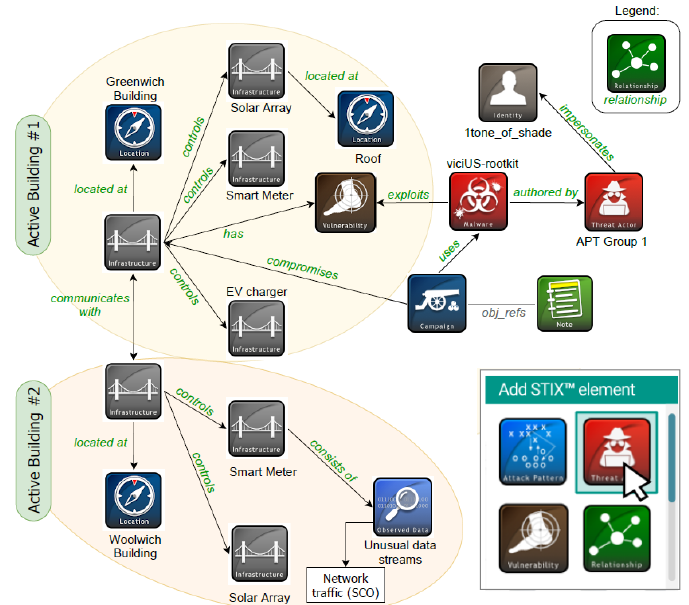
Figure 5. Base STIX model for active building as a graph manually simplified aiming for an intuitive representation. The arrows map relations among STIX elements.